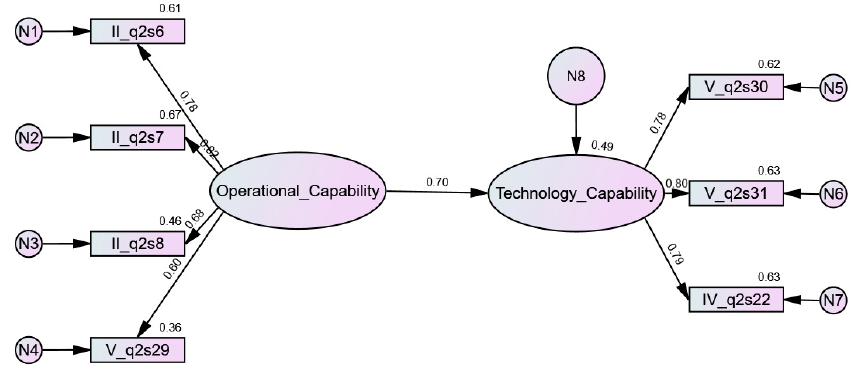
Figure 8. Regression model for organizational e-readiness (standardized estimates). Based on the structural model, the null hypothesis H0 was rejected in favor of the alternative hypothesis H1. There was a significant influence of the latent factor OC on the second latent factor TC. The structural coefficient on the path between these variables (0.697, Table 11, Figure 8) indicated the rate of change of the dependent variable from the independent variable. The model explained 48.6% of the TC variance. All model fit indices were excellent (Table 12). Table 11. Standardized and unstandardized model paths loadings.